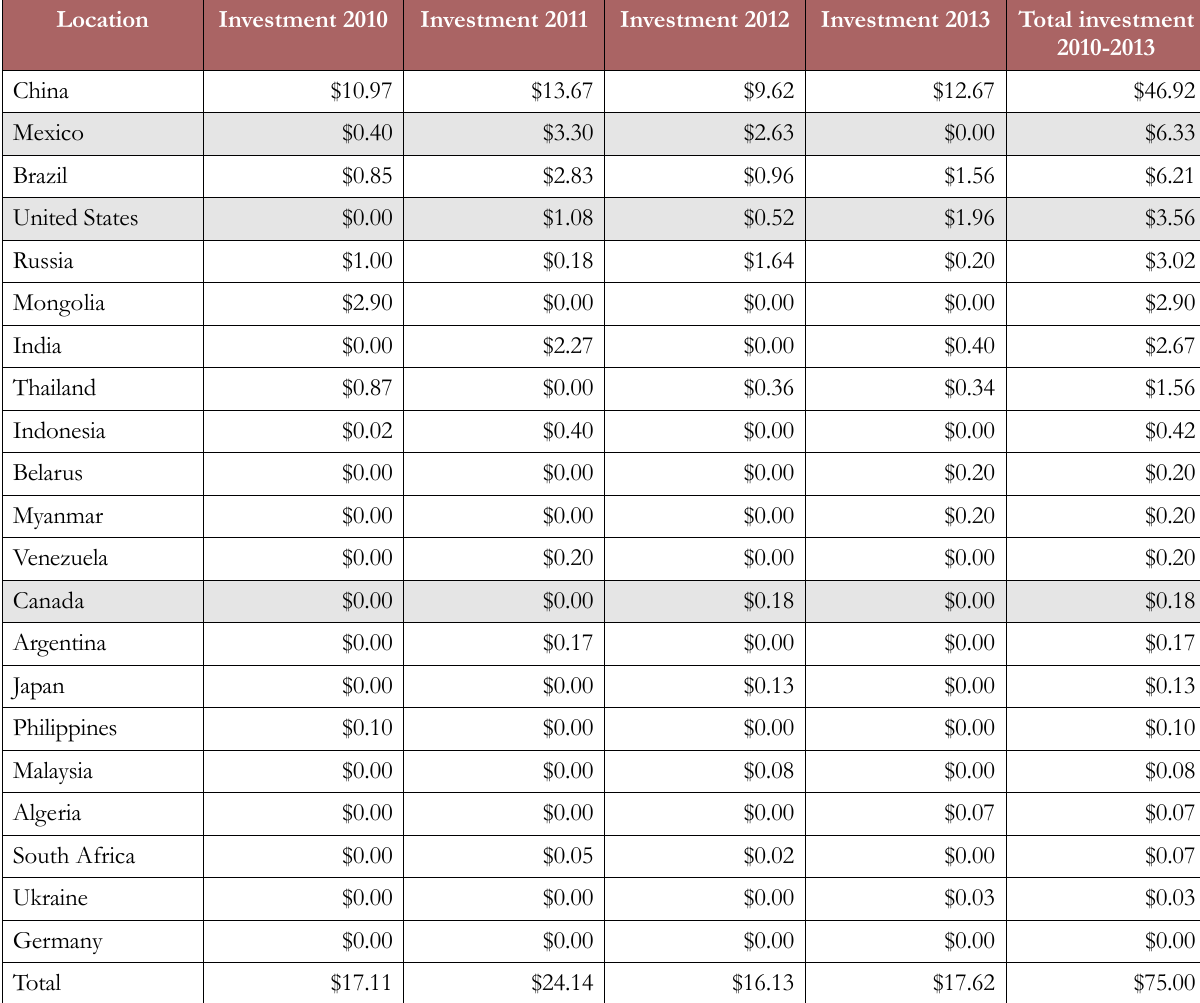
Table 12. Automotive industry investments in Billions